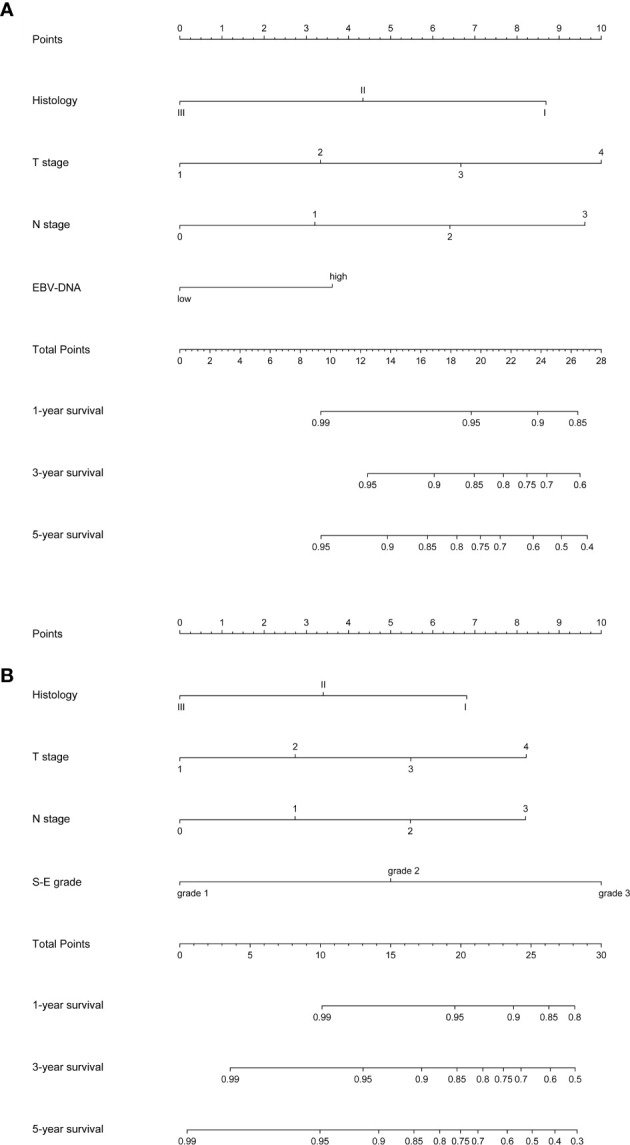
Nomograms to predict 1-, 3- and 5-year overall survival (OS). EBV-DNA = Epstein-Barr virus DNA; S-E grade = sarcopenia EBV-DNA grade. (A) Nomogram A, including histology, T stage, N stage, and EBV-DNA levels, for 1-, 3- and 5-year OS. The nomogram allows the user to obtain the probability of 1-, 3- and 5-year OS corresponding to a patient’s combination of covariates. As an example, locate the patient’s T stage and draw a line straight upward to the “Points” axis to determine the score associated with that T stage. Repeat the process for each variable, and sum the scores achieved for each covariate, and locate this sum on the “Total Points” axis. Draw a line straight down to determine the likelihood of 1-, 3- and 5-year OS; (B) Nomogram B, including histology, T stage, N stage, and S-E grade, for 1-, 3- and 5-year overall survival (OS). The nomogram allows the user to obtain the probability of 1-, 3- and 5-year OS corresponding to a patient’s combination of covariates.